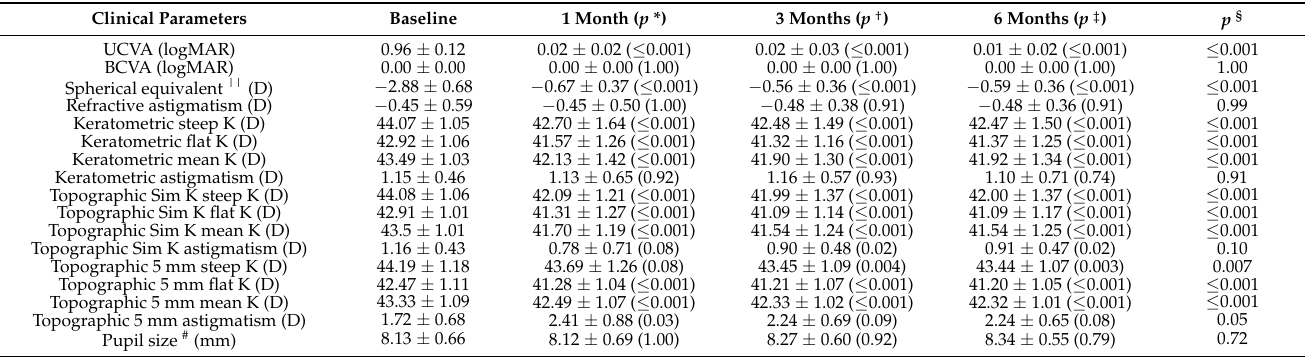
Table 2. Changes in refractive, keratometric and topographic values after wearing Orthokeratology lens (mean ±